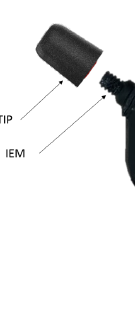
Figure 2. In-ear power sensor: Left cup earphone with foam tip.